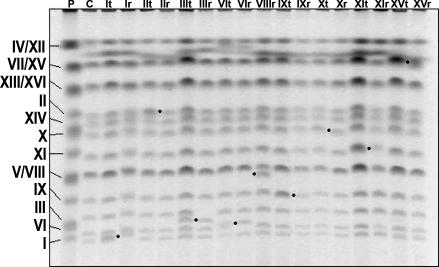
CHEF Gel Showing S. paradoxus Chromosome Transfers and Replacements in S. cerevisiae GametesNegative digital image of a CHEF gel. Replaced chromosomes are indicated by an asterisk to the left of the S. paradoxus band. S. paradoxus Chromosomes I, III, VI. and VIII are a different size than their S. cerevisiae homeologs and can be readily identified. The remaining transfers were verified by quantitative image analysis of the high-intensity band produced by the disomic chromosome (see Materials and Methods). Lanes: P, S. paradoxus YDG749; C, S. cerevisiae YDG 780; It, S. cerevisiae haploid with additional (disomic) Chromosome I transferred from S. paradoxus; Ir, S. cerevisiae haploid with Chromosome I replaced by Chromosome I from S. paradoxus; etc.